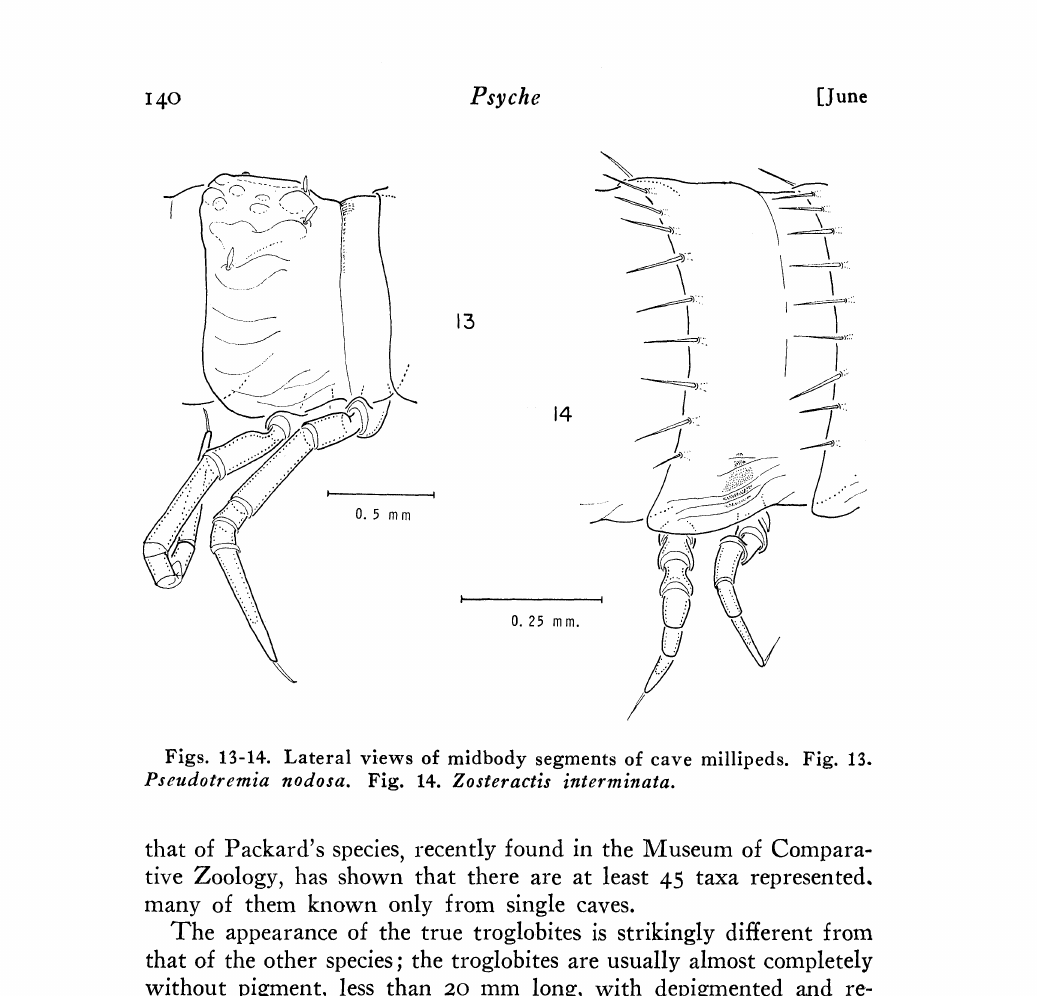
Figs. 13-14. Lateral views of midbody segments of cave millipeds. Fig. 13. Pseudotremia nodosa. Fig. 14. Zosteractis